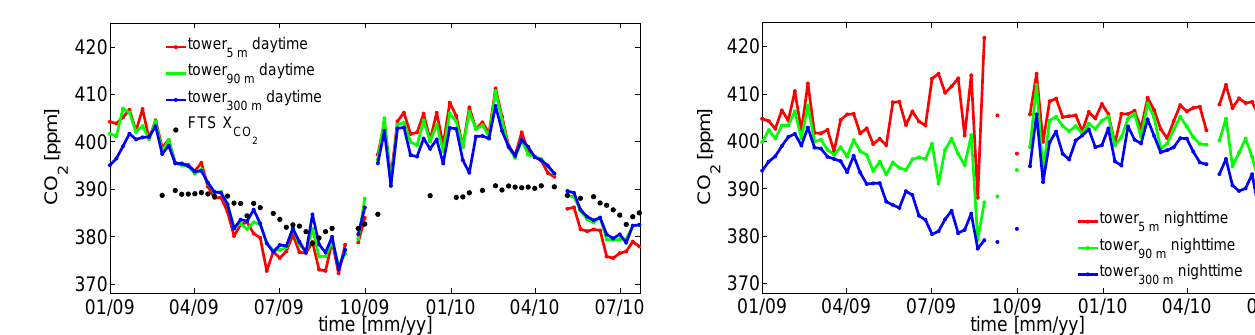
Fig. 5. The daytime CO 2 time series for three tall tower levels (5m, 90m, 300m) highlighting the seasonal cycle in compari- son with the FTS measurements. All measurements are shown as weekly averages of daytime measurements between 12:00p . m . and 03:00p . m . LT. Gaps in the data records are due to instrumental problems.